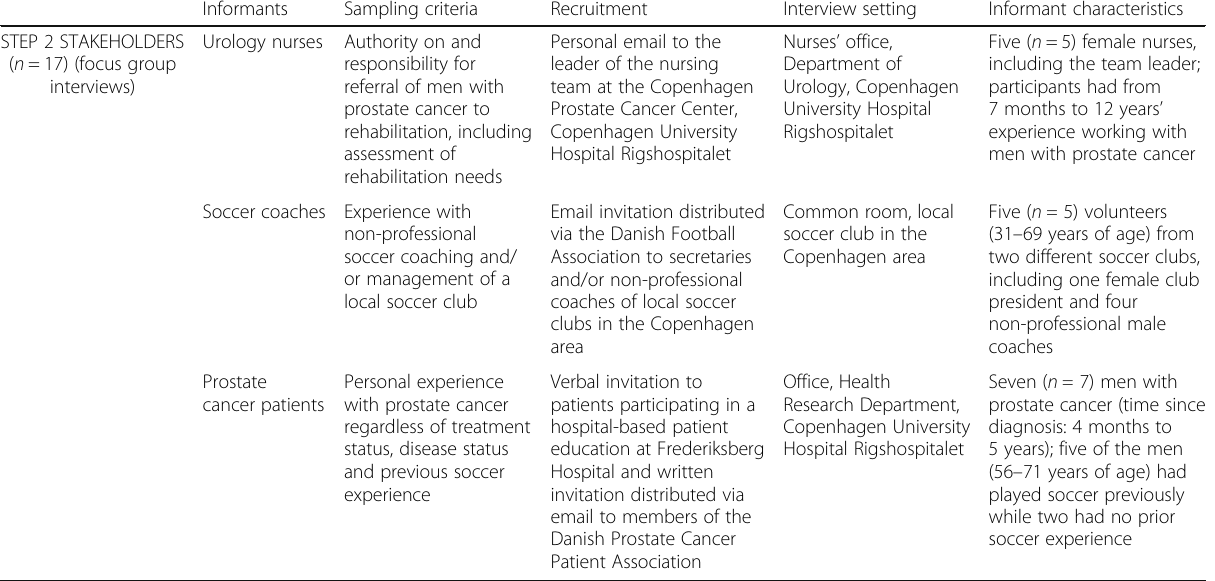
Table 2 Sampling, recruitment, and characteristics of stakeholders in step 2